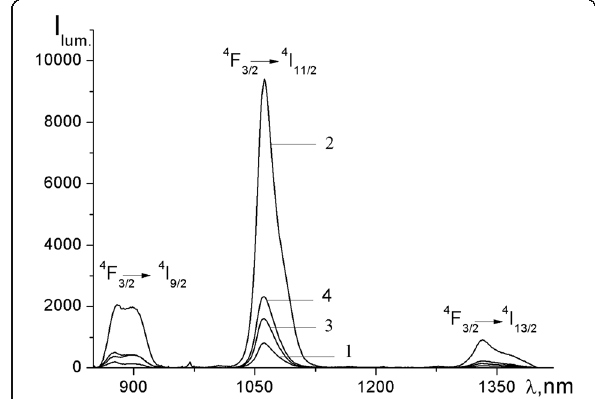
Fig. 6 Emission spectra of Nd(mphpd) 3 ( 1 ), [Nd(mphpd) 3 ] n ( 2 ), [Nd(mphpd)